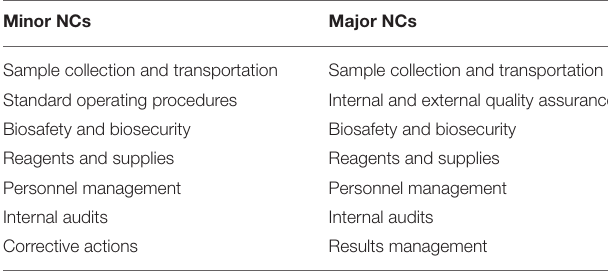
TABLE 4 | Summary of reported non-conformities identified from the 84 COVID-19 testing laboratories audited in the African region,